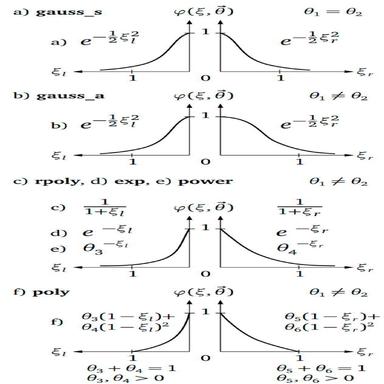
Different shape functions.